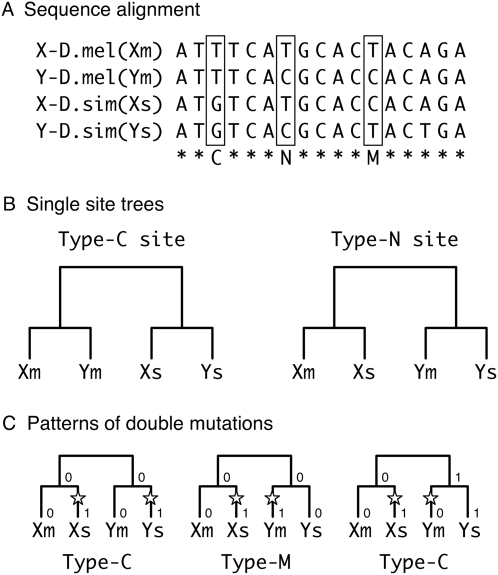
Illustrations to describe the analysis of informative sites in the alignment of the four sequences.(A) Example of the alignment of the four sequences. The types of informative sites are shown below the alignment: “C” and “N” are as defined in the text, and “M” represents a site that requires multiple mutations for explanation. (B) Relationships of the four sequences at type-C and type-N sites. (C) Patterns of double mutations. A double-mutated site is defined as one with a single substitution that has occurred since the speciation event in each of X and Y.